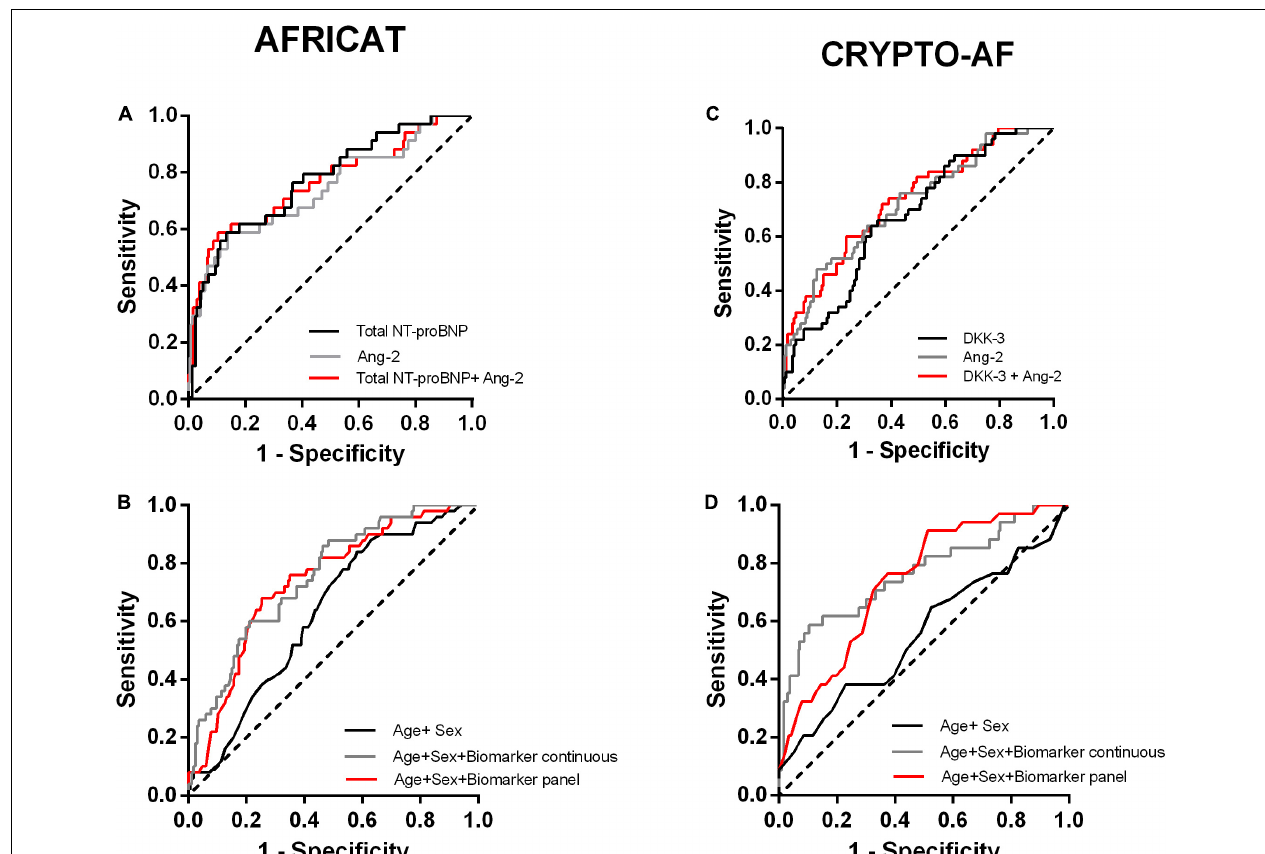
FIGURE 3 | Receiver operating characteristic (ROC) curves of the constructed models for the two cohorts. (A, B) Performance of the models constructed for the AFRICAT cohort. (C, D) Performance of the models constructed for the CRYPTO-AF cohort. (A, C) ROC curves including Ang-2,Total NT-proBNP, or DKK-3 alone, and combined as continuous variables for each cohort. (B, D) ROC curves for the clinical model alone (Age + Sex) and in combination with the biomarkers as continuous variables or dichotomized according to the panel with the best accuracy.